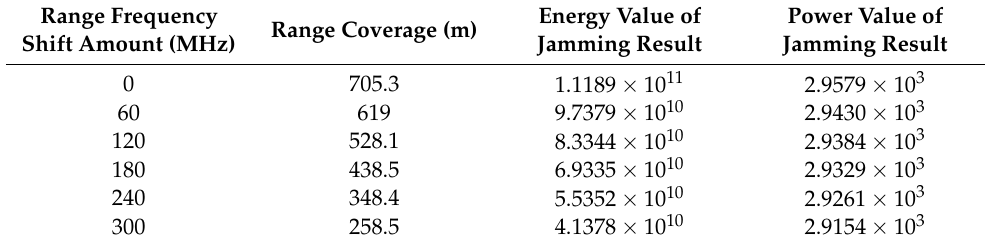
Table 3. Energy value and power value of the suppression jamming results under different range frequency shifts.